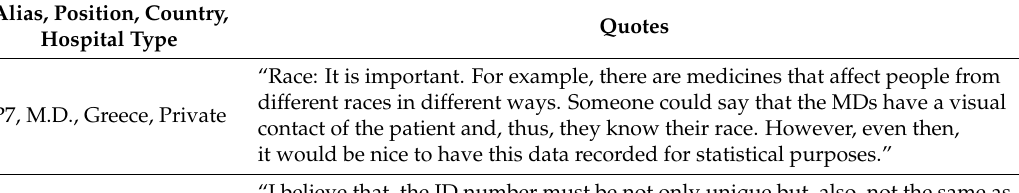
Table 1. Contents and structure of the EMR—significant